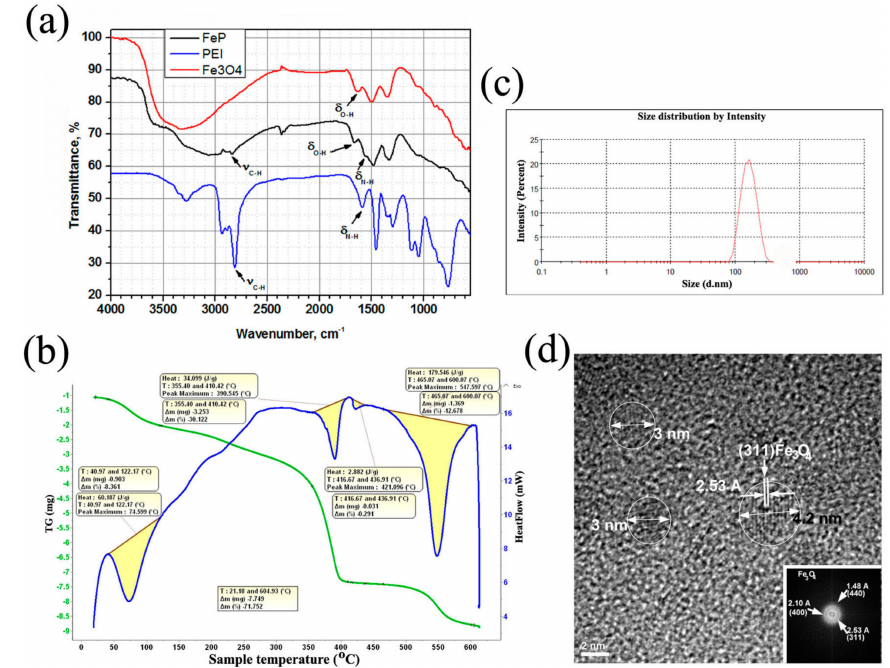
Figure 1. Characterization of Fe-PEI NPs. ( a ) FT-IR spectra of PEI and Fe-PEI nanohybrids; ( b ) DSC-TG thermograms of Fe-PEI showing three main endothermic peaks; ( c ) Particle size distribution of Fe-PEI hybrids; ( d ) HRTEM micrograph of Fe-PEI-based nanostructured hybrids. Inset illustrates interplanar distances corresponding to Miller indexes of magnetite